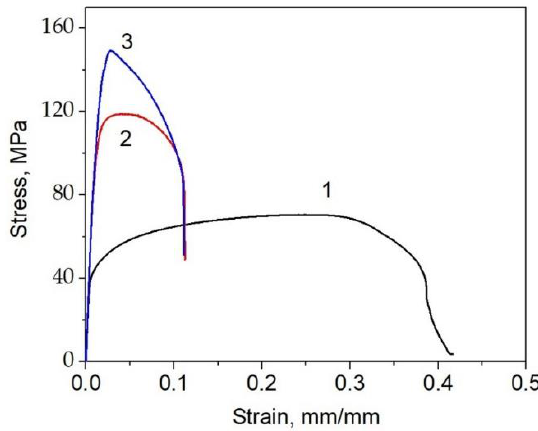
Figure 4. Typical alloy curves (1) without particles, (2) after two cycles of SPD and (3) after four cycles of SPD.